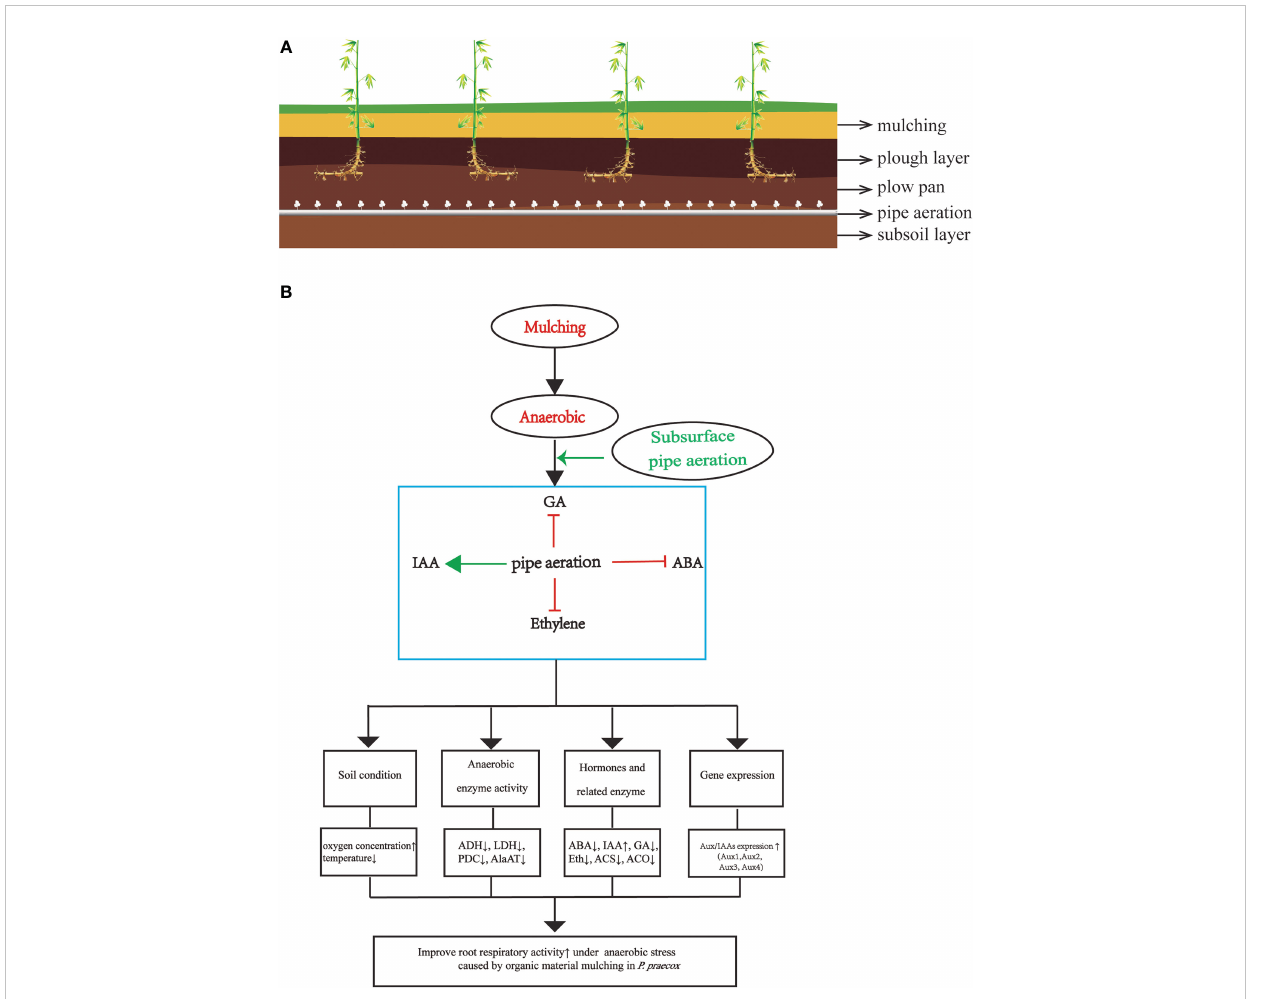
FIGURE 9 (A) the scheme of soil horizons including plants and air-pipe system; (B) a model for root aeration through hormone in P. praecox . Aeration promotes downstream protective systems in mulching via interacting with hormones (decreasing ABA, GA and ethylene content as well as increaseing IAA content), for instance, lowering soil temperature, anaerobic enzyme activity, increasing soil oxygen concentration, changing hormone synthase related activity, as well as increasing the expression of Aux/IAAs to stimulate root growth. Green arrow represents promotion, whereas red t-bars denote